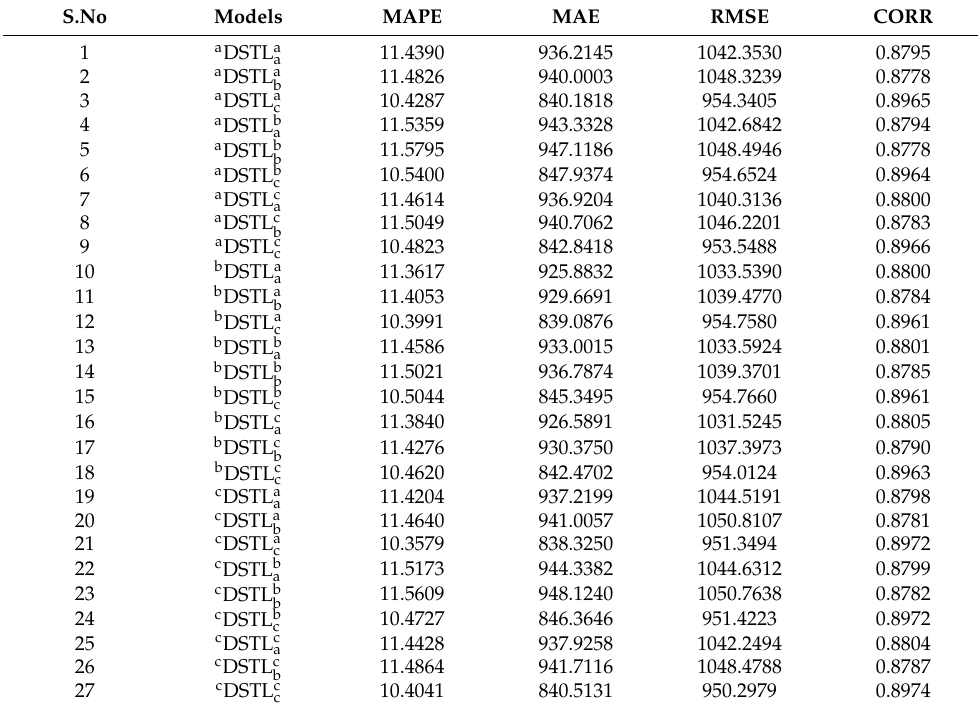
Table 4. Pakistan’s electricity consumption (kWh): out-of-sample one-month-ahead average forecast error for all models combined with the DSTL